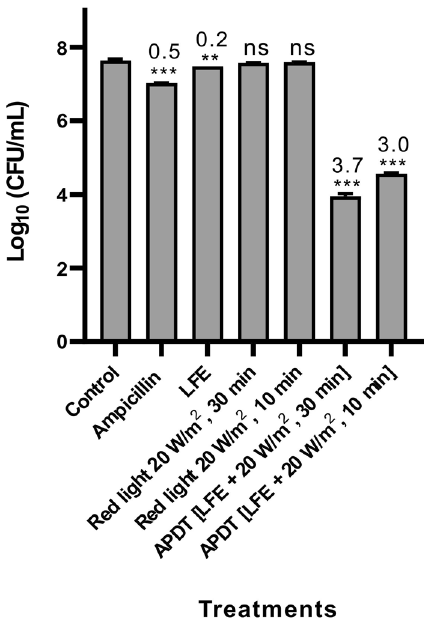
Fig. 3 In vitro antimicrobial activities of LFE under different light conditions. APDT with LFE (20 µg/mL; incubation time, 30 min) against MRSA under a red light intensity of 20 W/m 2 for 10 or 30 min. Ampicillin (100 µg/mL) was used as the positive control. The data are expressed as mean standard error (n 2) and representative of ± = three independences. ns indicates no statistical significance relative to the control group. Significant differences are expressed with ** for p < 0.01 and *** for p < 0.001 relative to the vehicle control. The log reductions compared with vehicle control are presented in each column